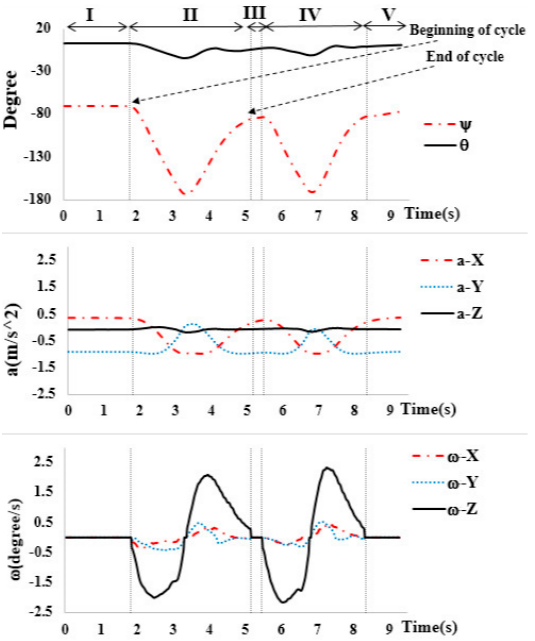
Figure 6. Signal from the IMU sensor working on two cycles.